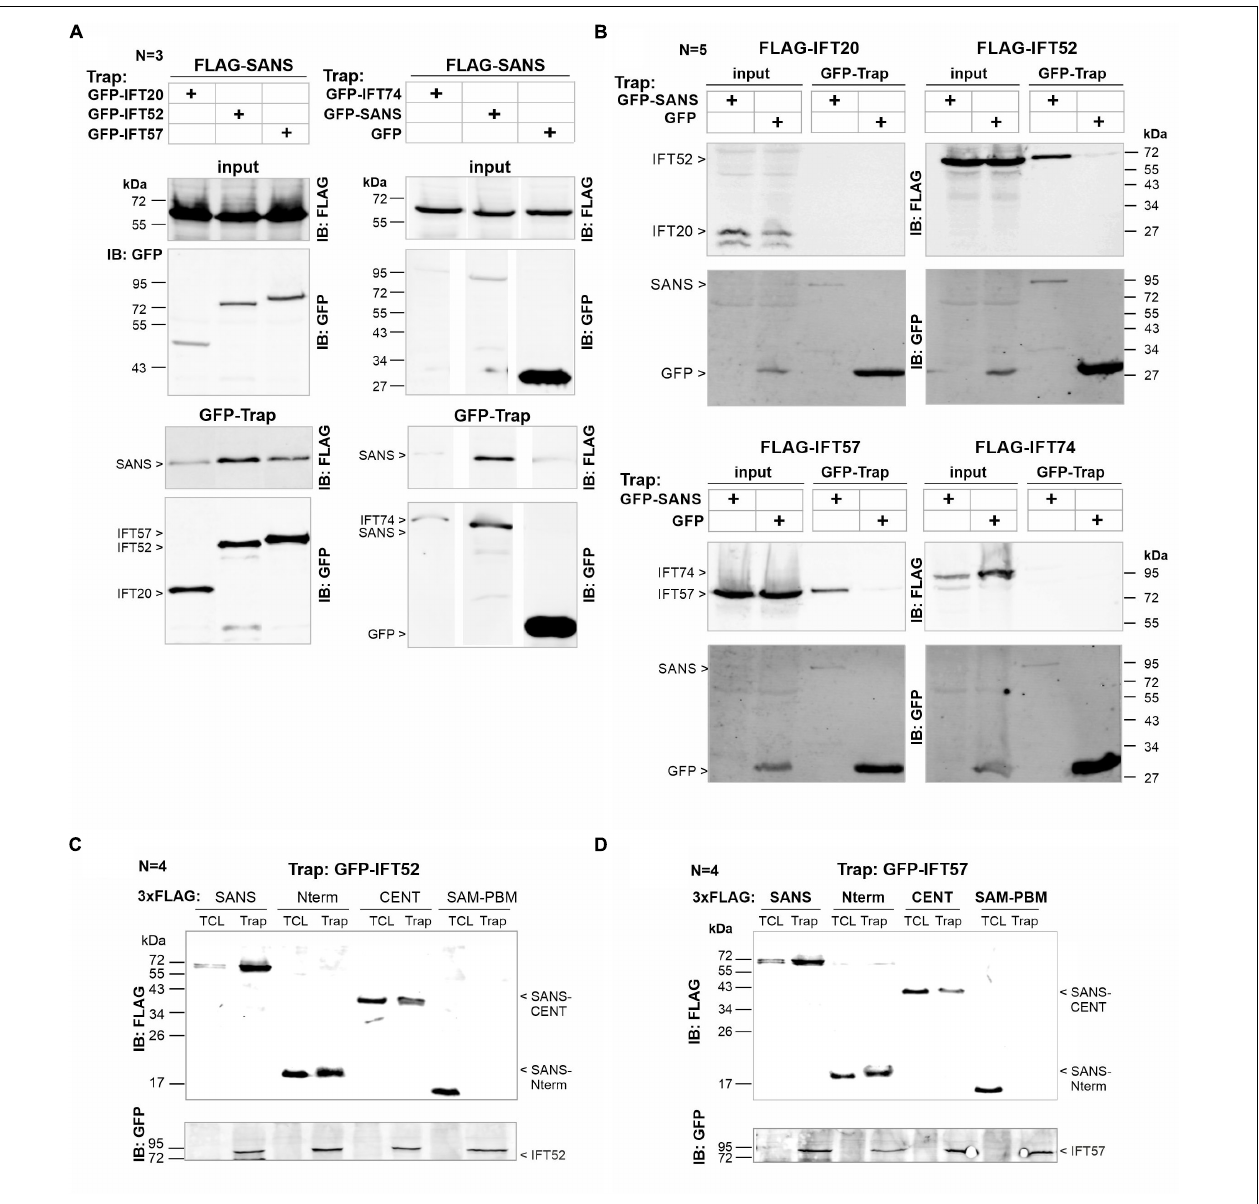
FIGURE 2 | Bidirectional confirmation of SANS’ interaction with IFT20, IFT52, and IFT57 in vitro . (A) Representative Western blot analysis of GFP-Trap of FLAG-SANS full-length by GFP-tagged IFT20, IFT52, IFT57, and IFT74, immobilized on GFP-Trap beads of three independent experiments. Controls: GFP-SANS (positive) and GFP alone (negative). FLAG-SANS was precipitated by IFT20, IFT52, IFT57 (upper panel), and GFP-SANS, but not by IFT74 or GFP alone (lower panel). (B) Representative Western bolt analysis of reciprocal GFP-Trap of FLAG-IFT20, FLAG-IFT52, FLAG-IFT57, and FLAG-IFT74 by GFP-SANS and GFP (control), respectively of five independent experiments. FLAG-tagged IFT52 and IFT57 were precipitated by GFP-SANS, immobilized on GFP-Trap beads, but not by GFP alone. No interaction was detected with IFT20 or IFT74. (C,D) Representative Western blot analyses of GFP-Trap of FLAG-SANS full length, Nterm, CENT, and SAM-PBM by GFP-tagged IFT52 and IFT5, respectively, immobilized on GFP-Trap beads. FLAG-SANS Nterm and FLAG-SANS-CENT were precipitated by both, GFP-IFT52 and GFP-IFT57.